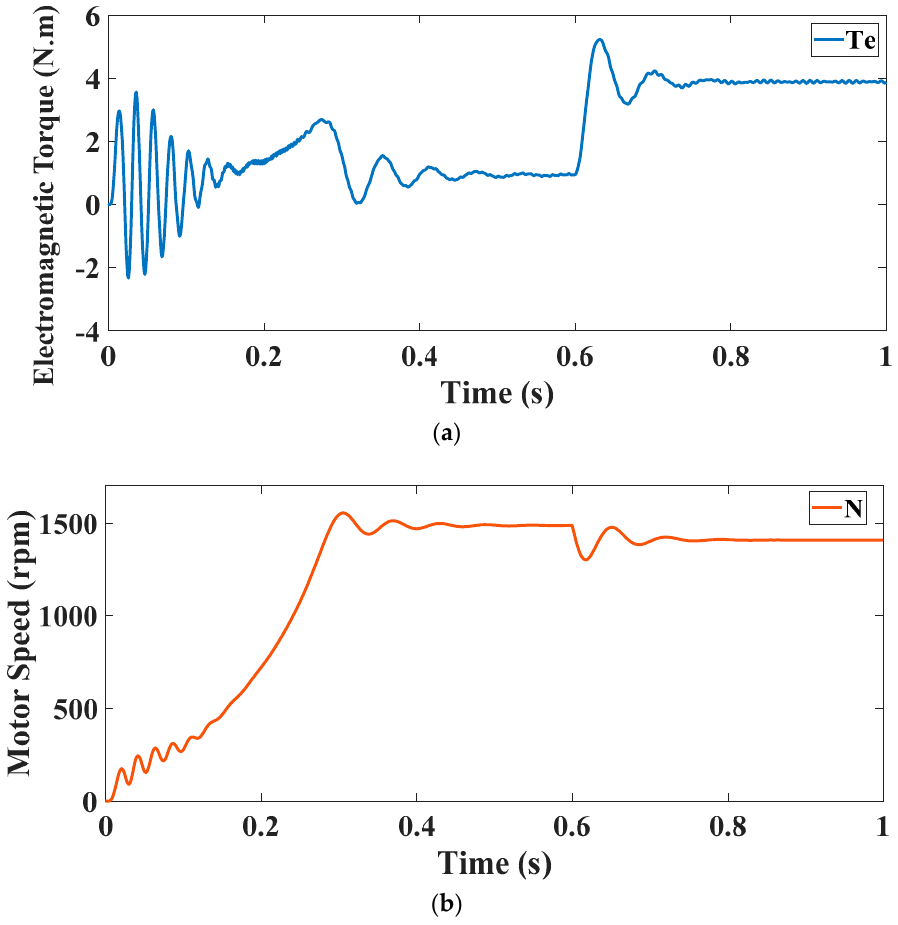
Figure 12. ( a ) Electromagnetic torque; ( b ) Rotor